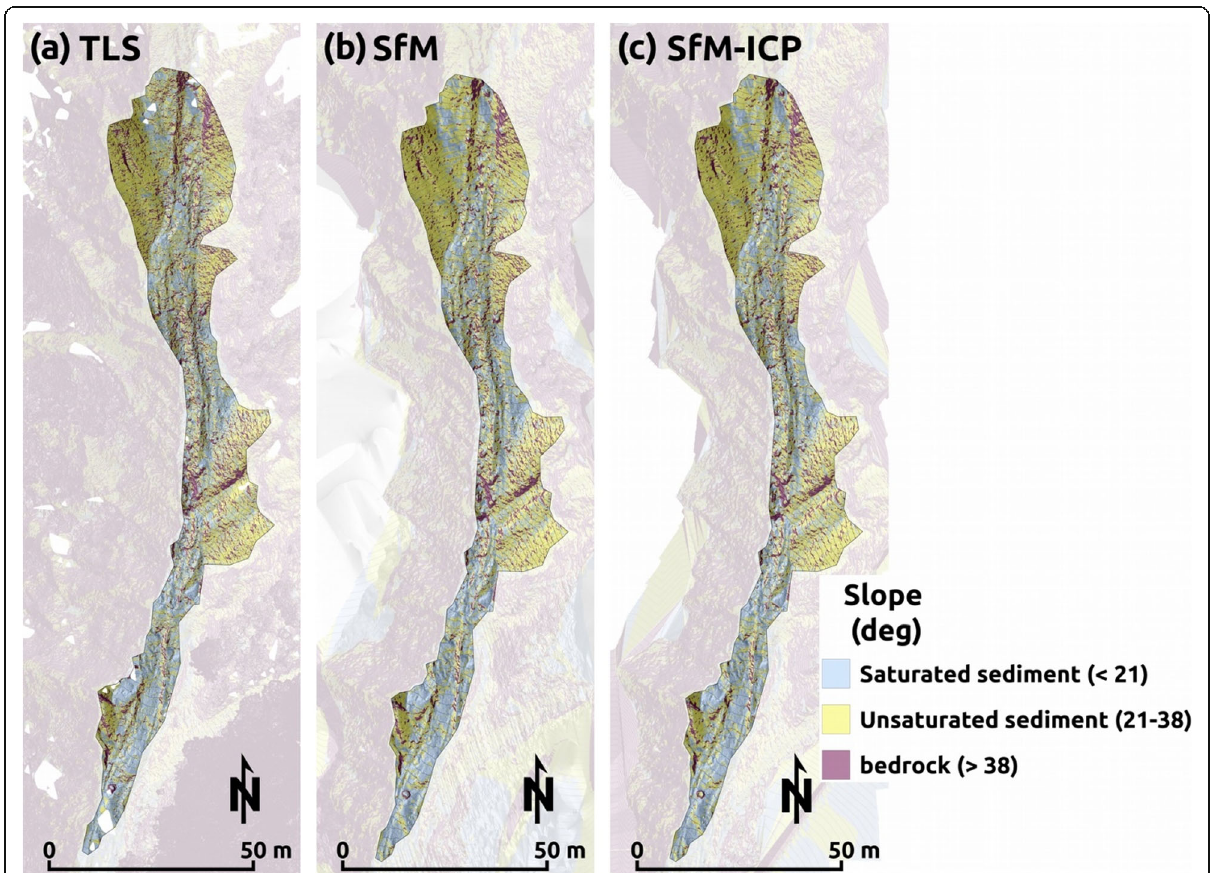
Fig. 8 Spatial distribution of slope domains. a DEM TLS . b DEM SfM. c DEM SfM-ICP . Slope domains were refereed, similar to Imaizumi et al.